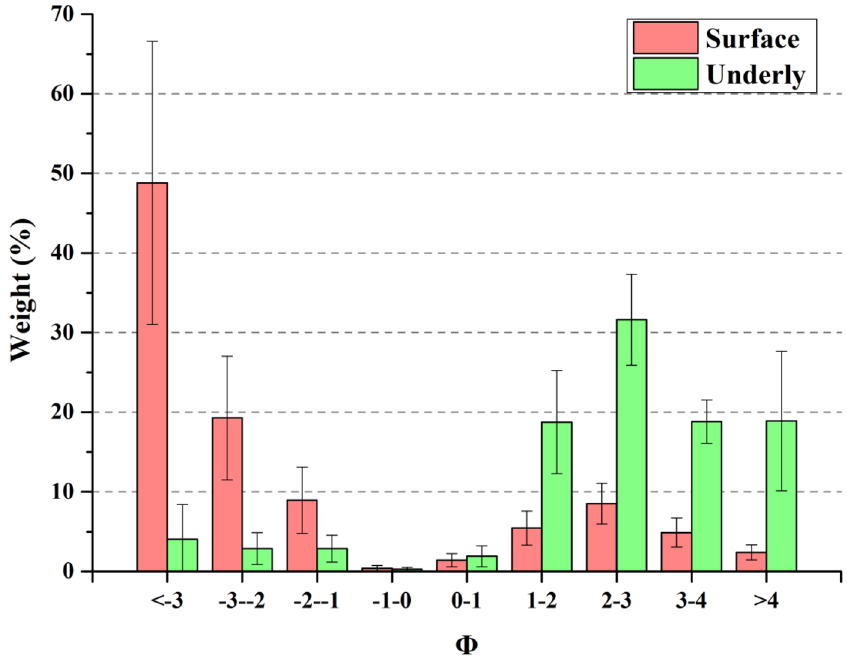
Figure 5. Grain size distribution of sediments on surface and underlying soil layers of gobi region in Ejina Qi.